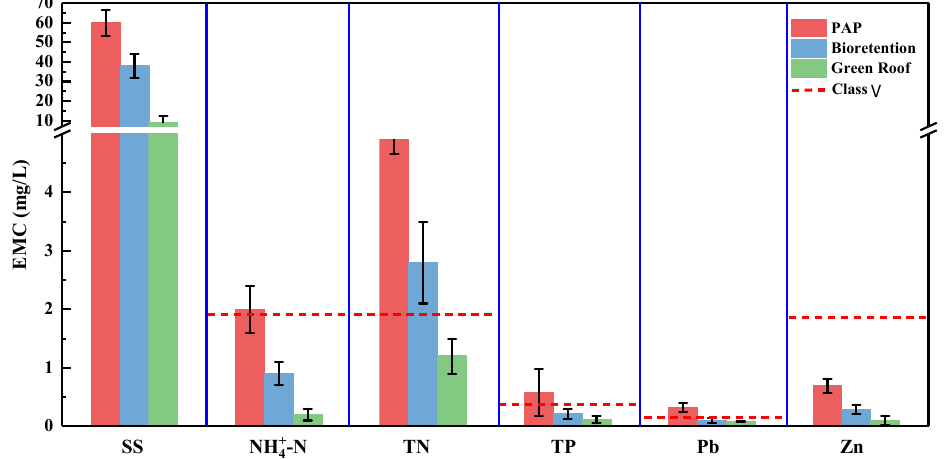
Figure 7. Event mean concentrations (EMCs) of pollutants in effluent produced by different components of the PBT-GR system. Abbreviations: SS, suspended solids; TN, total nitrogen; TP, total phosphorus (n = 6).